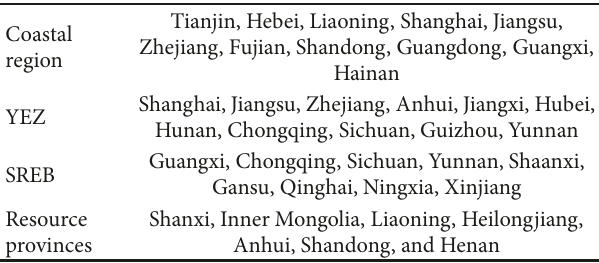
Table 1: Provinces included in the coastal region, the YEZ, and the SREB and the resource